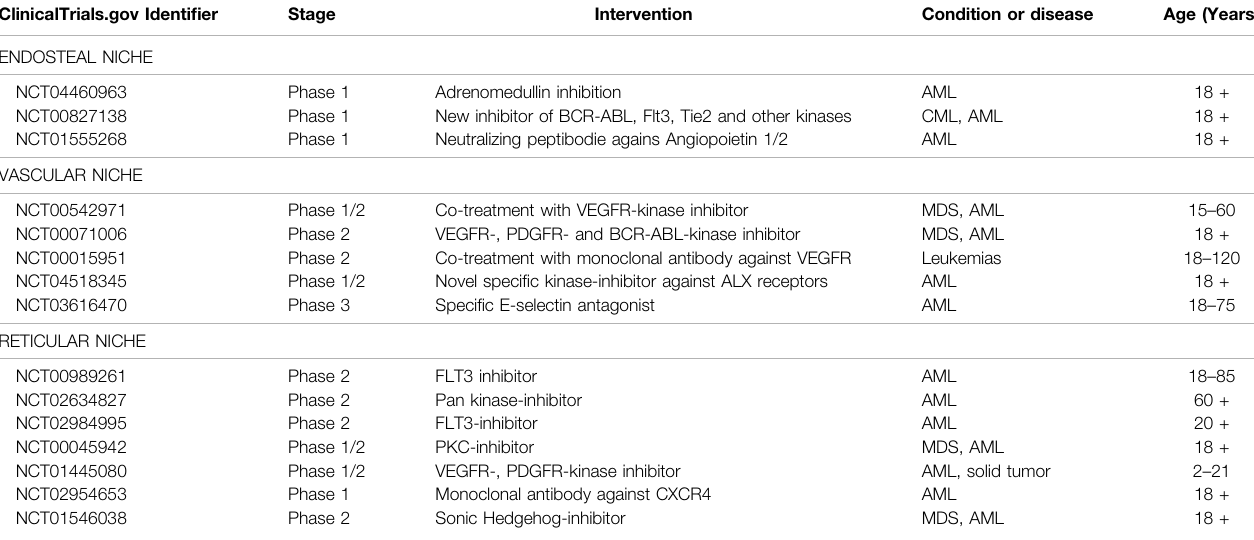
TABLE 1 | Studies registered on ClinicalTrials.gov investigating bone marrow niches-related molecular targets in AML. ClinicalTrials.gov Identi fi er